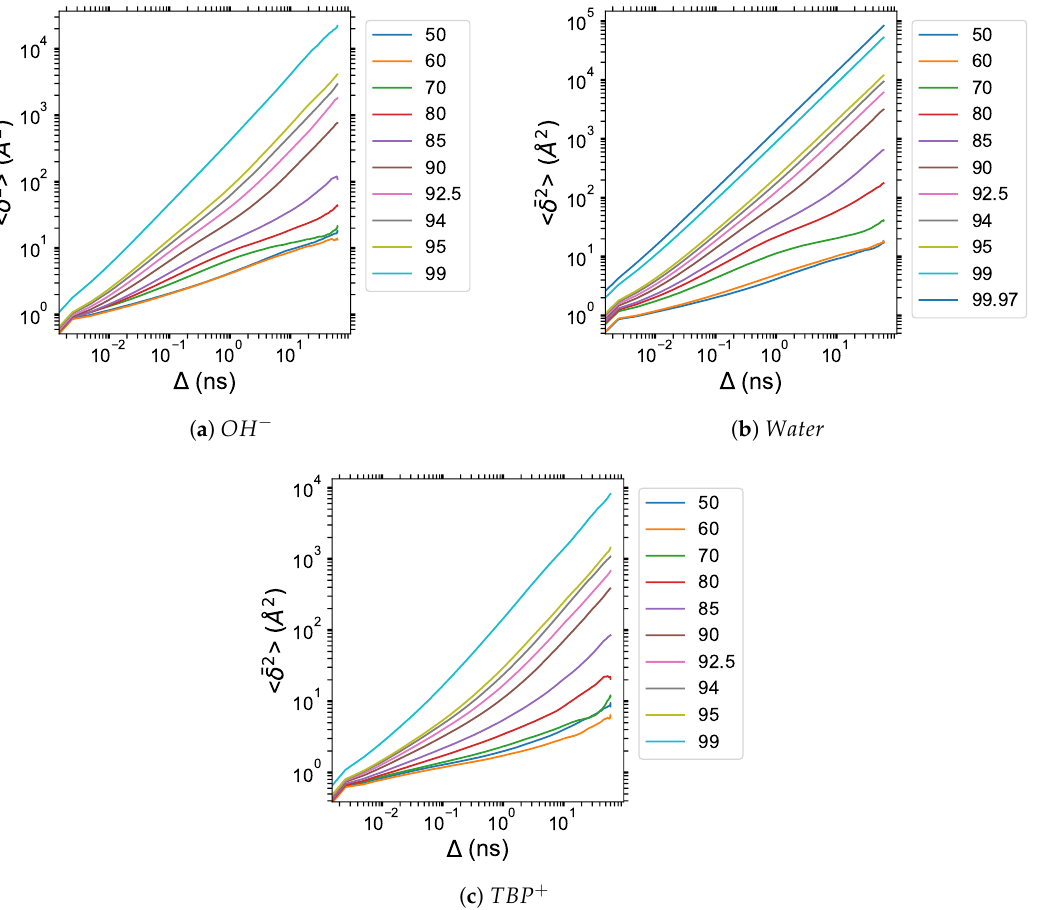
Figure 17. Particle-averaged time-averaged mean squared displacements (TAMSDs) of the TBPH–water solution at p = 1atm and T = 300K as a function of water concentration for: ( a ) OH − ; ( b ) water; ( c ) TBP +